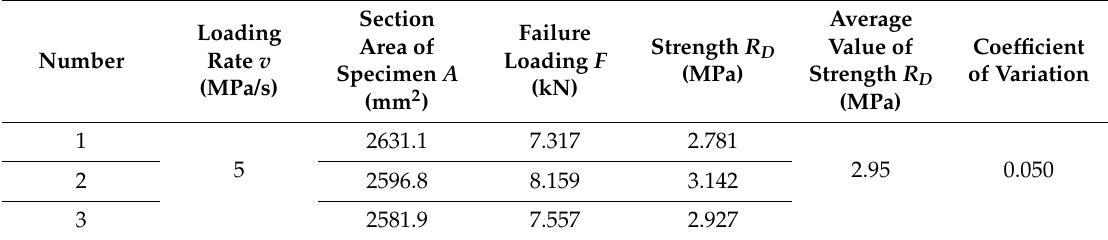
Table 5. Test results of direct tensile strength of asphalt